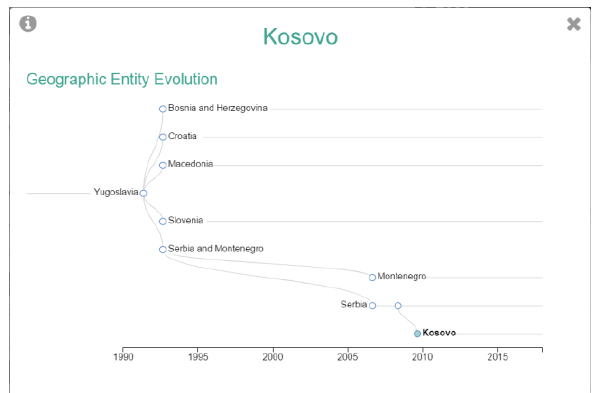
Figure 9. Geographic Entity